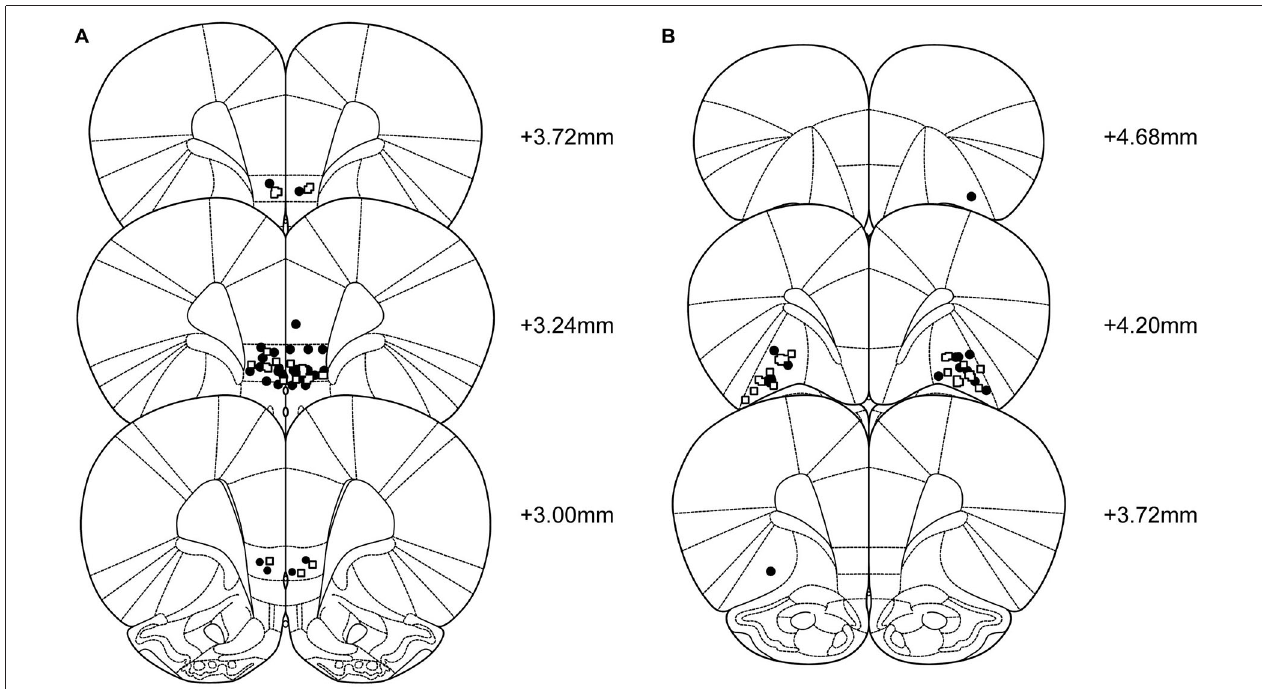
FIGURE 1 | Representation of the location of the infusions into the (A) infralimbic cortex (CORT: black circles, n = 21; vehicle: open squares, n = 13), and (B) lateral orbitofrontal cortex groups (CORT: black circles, n = 11; vehicle: open squares, n = 12). Sections correspond to the atlas of Paxinos and Watson